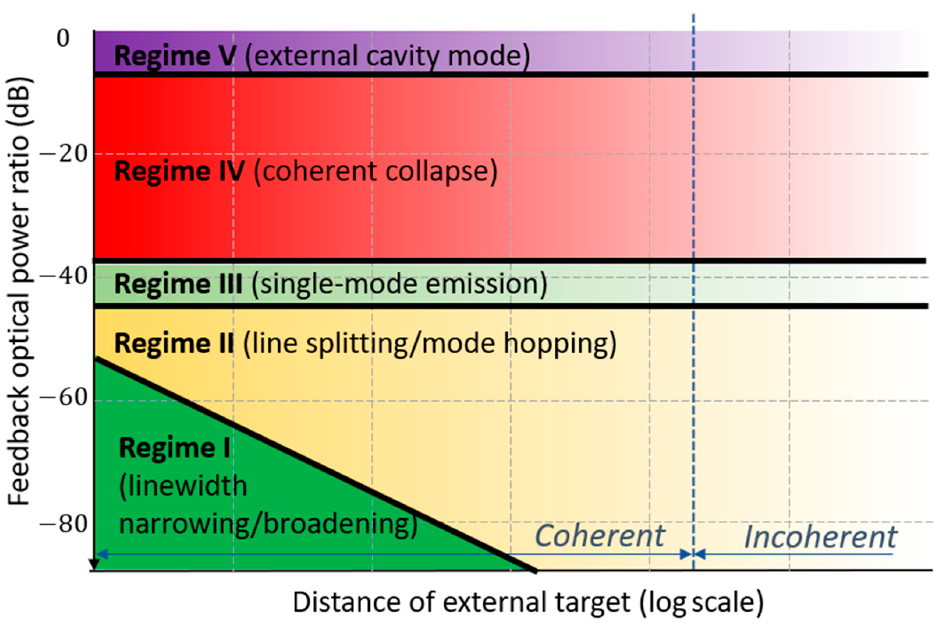
Figure 13. The five different regimes of laser feedback. Adapted from Refs. [129,130].